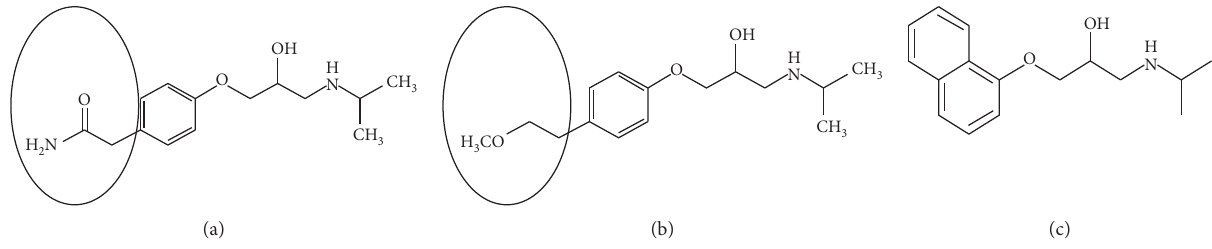
Figure 9: Chemical structure of β -blockers: atenolol (a); metoprolol (b); and propranolol (c) [52].